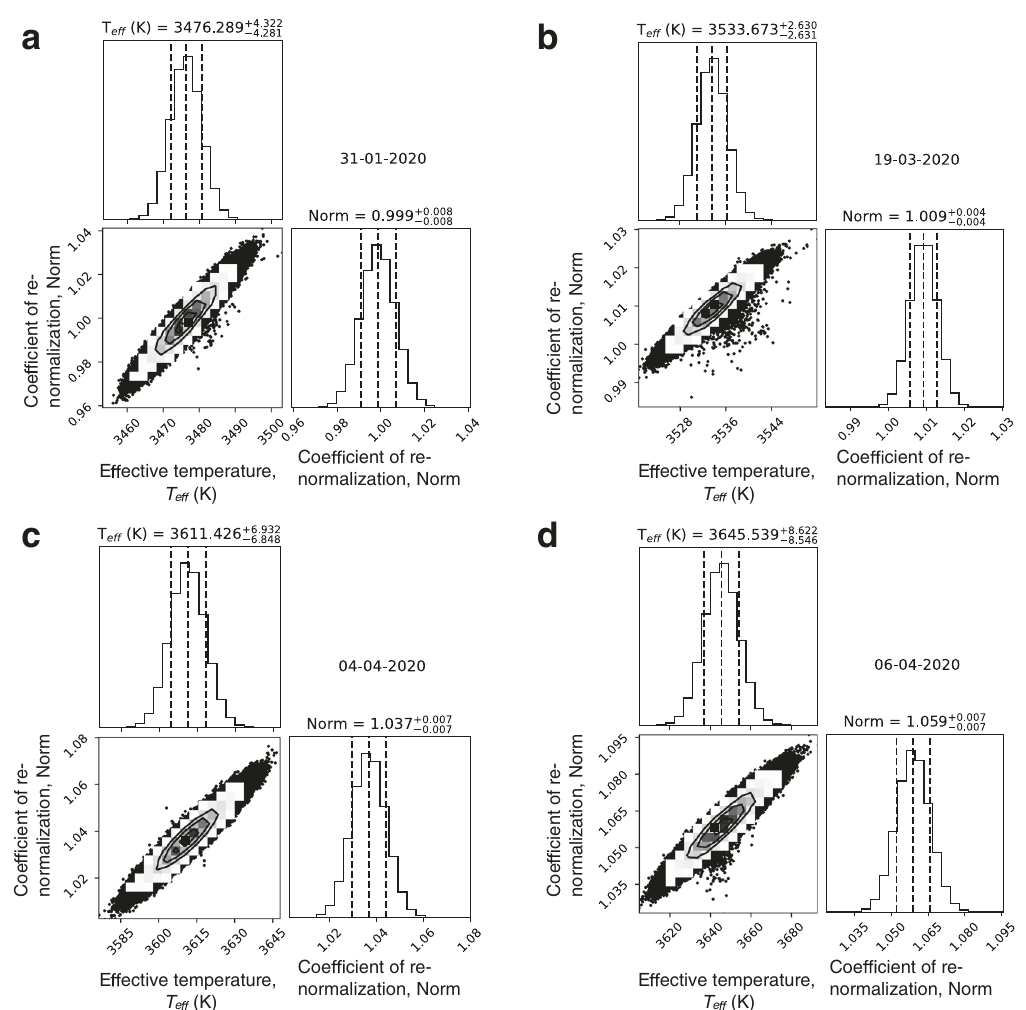
Fig. 6 Four corner plots with the fi nal effective temperatures ( T eff ) of Betelgeuse obtained at four epochs 31-01-2020, 19-03-2020, 04-04-2020, and 06-04-2020. a The best- fi t T eff and its uncertainties were obtained on 31-01-2020. The panel corresponding to the fi t of the region at 7700 – 7900 Å is shown in Supplementary Fig. 4a. b The best- fi t T eff and its uncertainties were obtained on 19-03-2020. The panel corresponding to the fi t of the region at 7700 – 7900 Å is shown in Supplementary Fig. 4b. c The best- fi t T eff and its uncertainties were obtained on 04-04-2020. The panel corresponding to the fi t of the region at 7700 – 7900 Å is shown in Supplementary Fig. 4c. d The best- fi t T eff and its uncertainties were obtained on 06-04-2020. The panel corresponding to the fi t of the region at 7700 – 7900 Å is shown in Supplementary Fig. 4d. On each panel, the diagonal shows the marginalized posteriors. The subsequent covariances between all the parameters are in the corresponding 2D histograms. The vertical lines represent the 16, 50, and 84 percentiles. The best- fi t parameters for T eff and their uncertainties are presented on the top of each panel. Uncertainty for T eff is de fi ned as the difference between the 84th and 50th percentile as the upper limit, and the difference between the 50th and 16th percentile as the lower limit. The data of observations are marked in dd-mm-yyyy